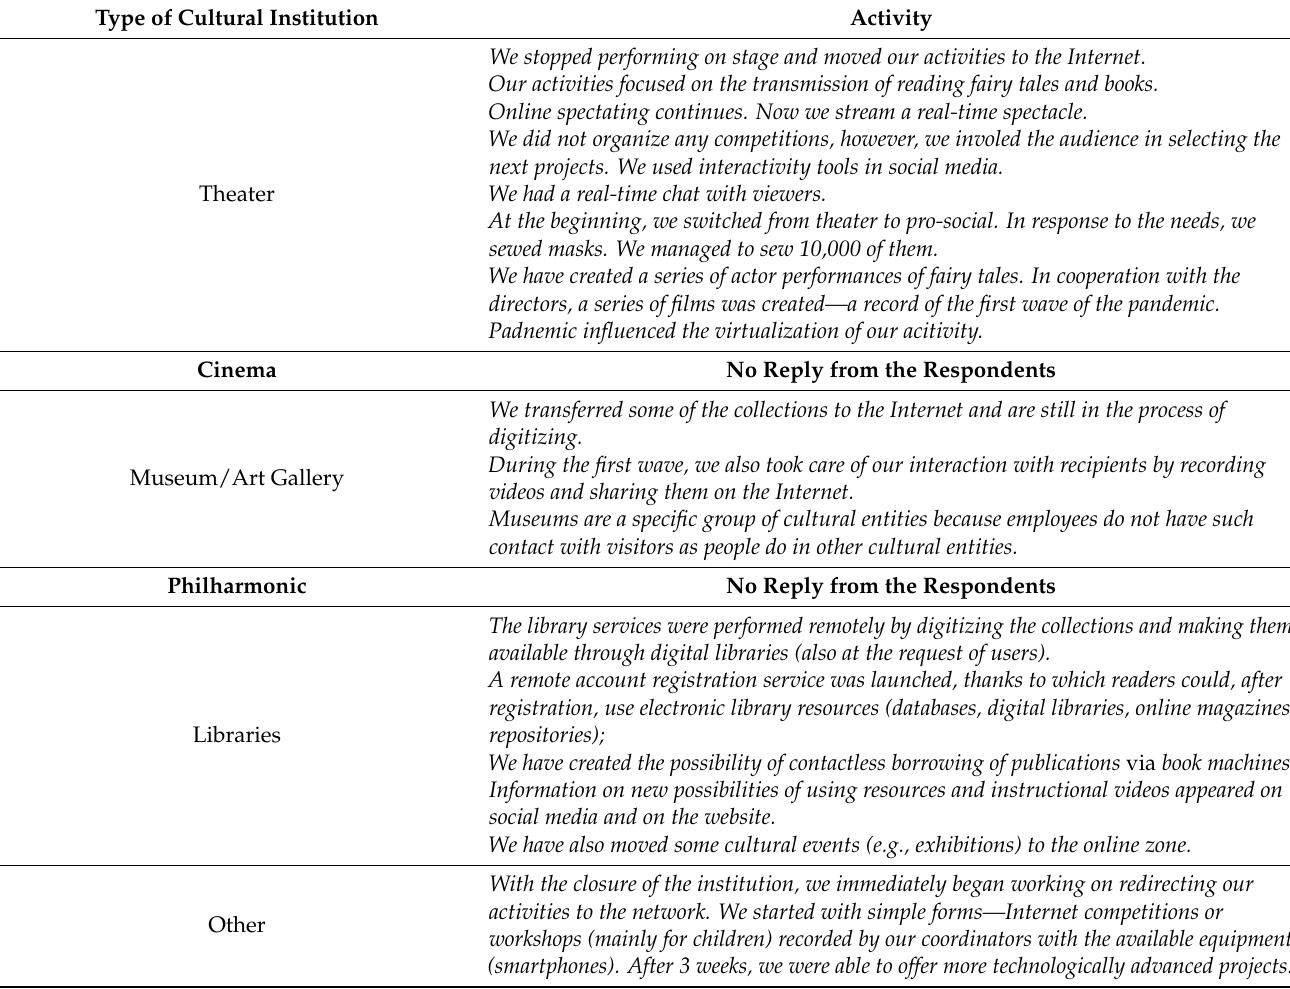
Table 1. Comparison of the impact of the outbreak of the COVID-19 pandemic on the activities of cultural institutions in ´Sl ˛askie Voivodeship—IDI results.